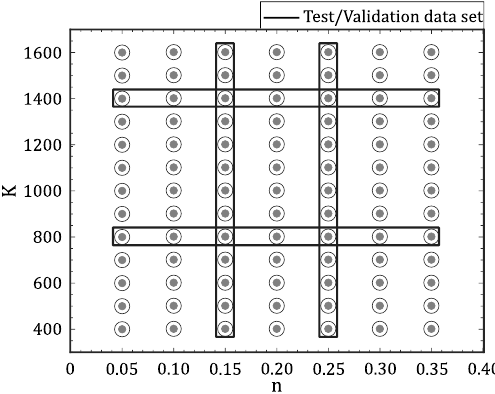
Figure 12. Selected data sets for problem